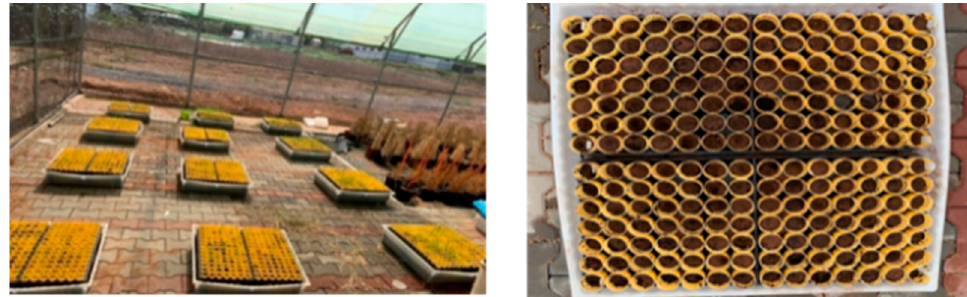
Figure 1. Cone-tainer system installed in a net house.